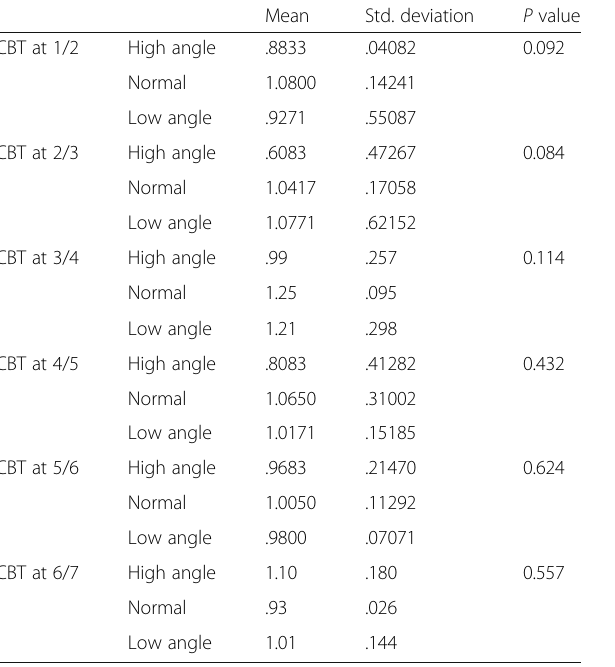
Table 3 Measurements of palatal inter-radicular cortical bone thickness at 4 mm from the alveolar crest in the upper arch